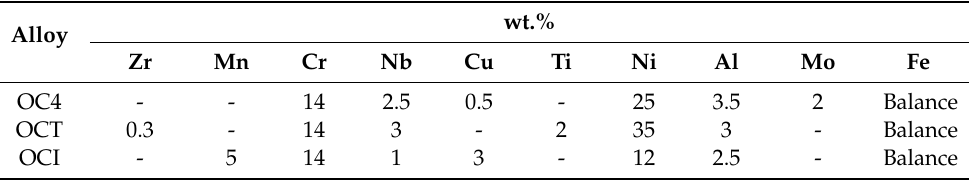
Table 2. Chemical composition of the tested